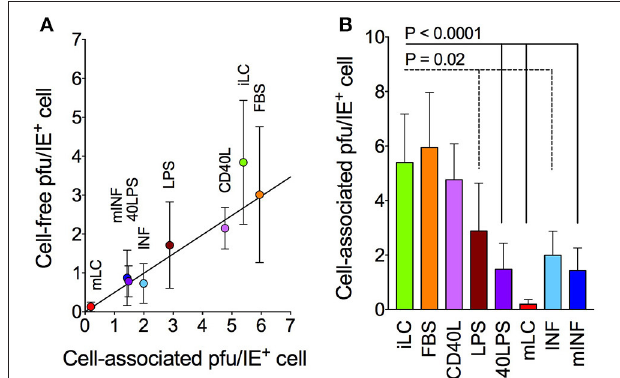
FIGURE 3 | Cell-free and cell-associated progeny yields in infected LC cultures. Immature and activated LC were infected with TB40/E at an MOI of 10, and the amount of cell-associated virus per IE + cell present at days 6–10 was calculated (B) and plotted against the amount of cell-free virus per IE + cell present in each medium during the same time frame (A) . The best-fitting line modeling the relationship between the X and Y values of all data points was identified by linear regression ( Y = 0.5 X , R 2 = 0.96). Symbols represent the median and median absolute deviation values of data collected with LC derived from three different CD34 + cell donors in three independent experiments, and from three donors in two independent experiments (40LPS condition). The P -values for pairwise comparisons of data distributions using the KS test are